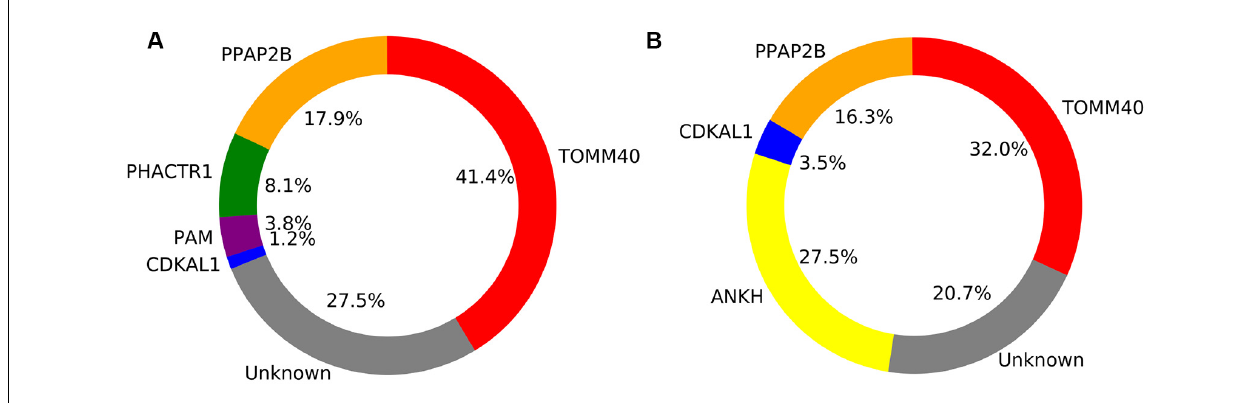
FIGURE 5 | Pie chart showing the percentage of explained variance for each gene retained in the general linear model for Healthy adults (A) and Alzheimer’s disease (AD) patients (B) .